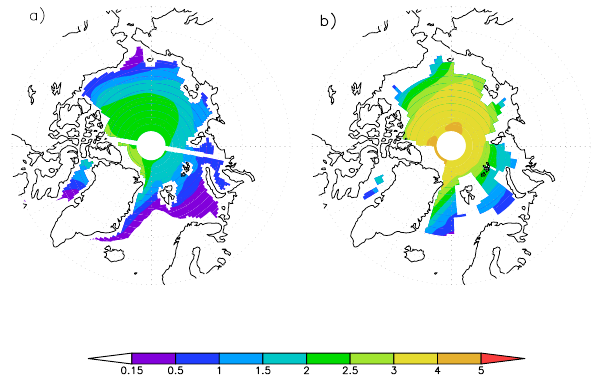
Fig. 4. Ensemble mean minimum sea-ice thickness in the pre- industrial simulations for (a) the PMIP3 ensemble and (b) the PMIP2 ensemble. The white line in the left figure is caused by the definition of the ocean model-grid in one of the models.